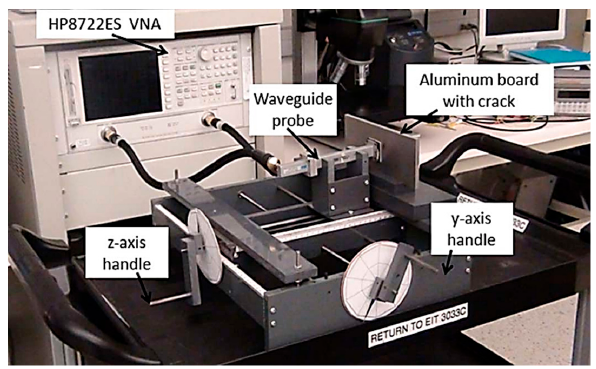
Figure 24. Con fi guration of the experimental setup. The probe is fi xed to the support by a tight fi t craft and can be moved along the y axis by turning the handle. The precision for moving the probe is 0.1 mm/step (from [40]; copyright © IEEE 2014; reproduced with permission).